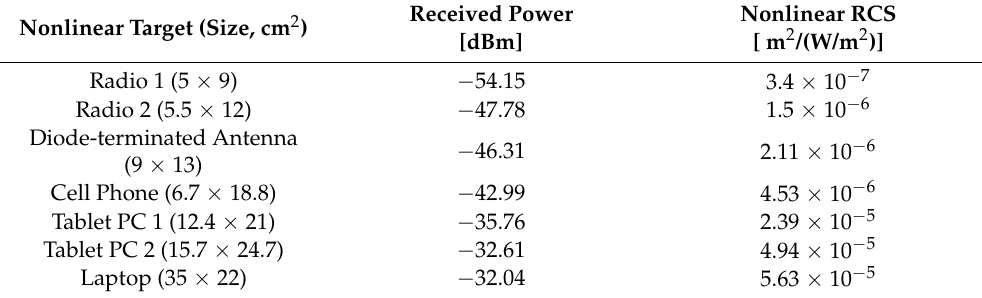
Figure 4. An example of the received harmonic response from target (laptop). Table 1. Various nonlinear targets and their estimated nonlinear RCS based on the received power [30]. Nonlinear Target (Size, cm 2